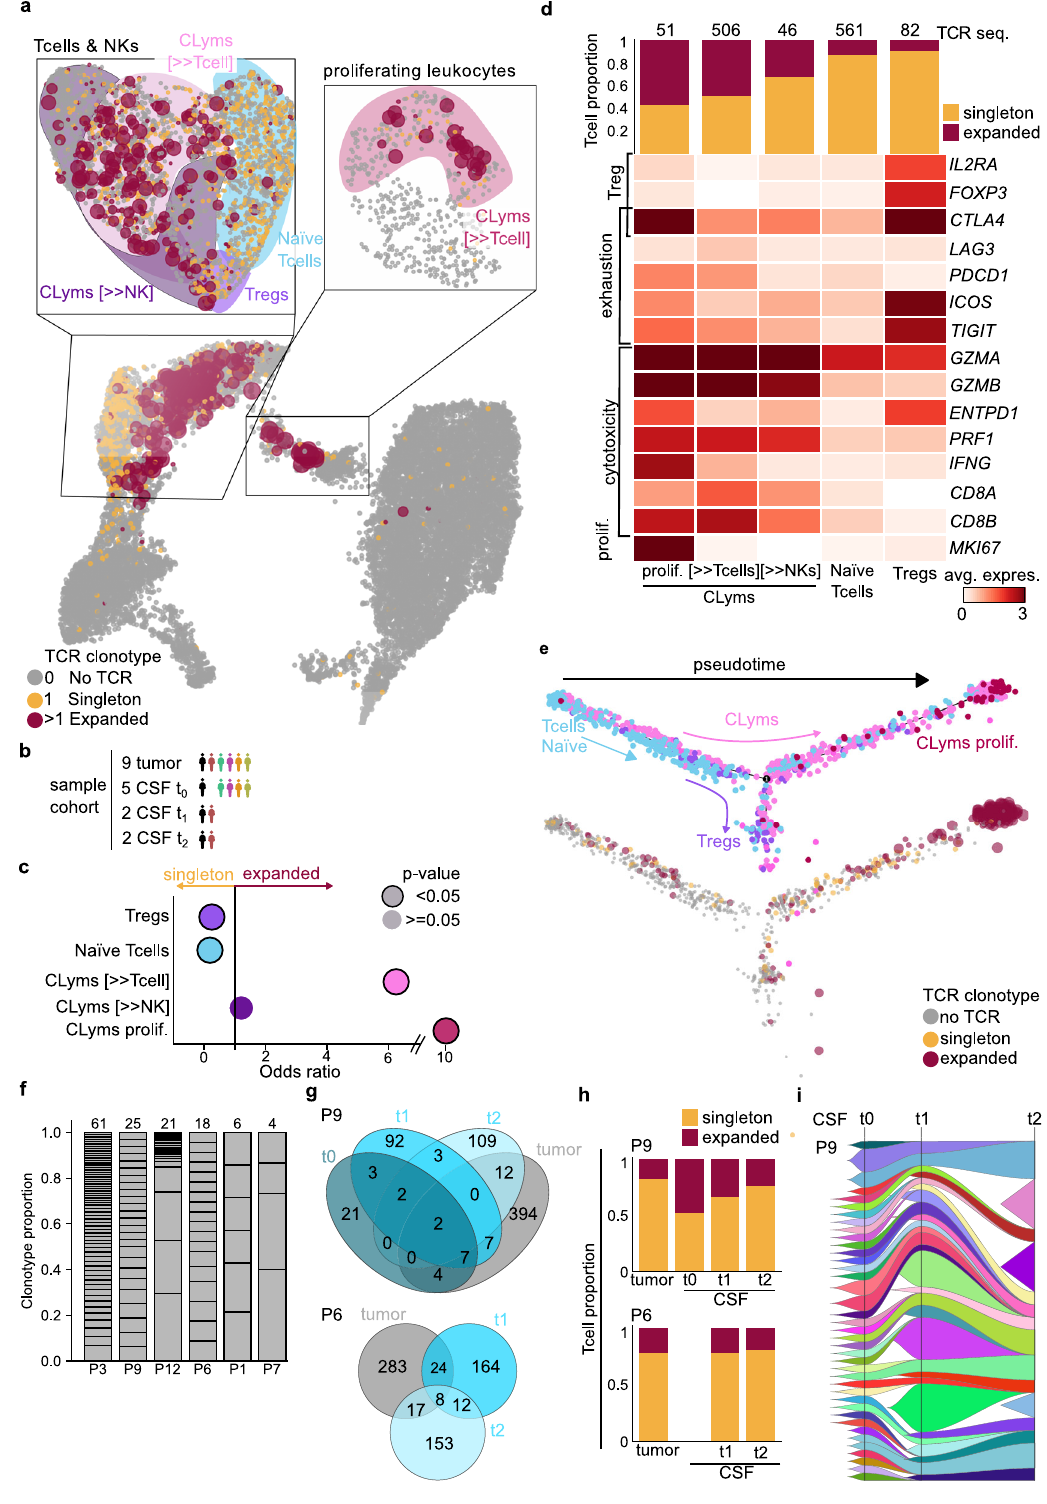
Targeted RNA pro fi ling . RNA from 48 BrM samples was extracted and expression levels for 730 immune-related and 40 additional housekeeping genes were obtained, through PanCancer Immune Panel v1 (Nanostring ® ) 30 . A minimum of 250 ng of total RNA was used as input of Nanostring Pancancer Immune Pro fi ling panel. Expression levels for 730 immune-related and 40 additional housekeeping genes were obtained. Samples with a geometric mean expression lower than 50 counts in the housekeeping genes were discarded due to low quality (Supplementary Fig. 1c).